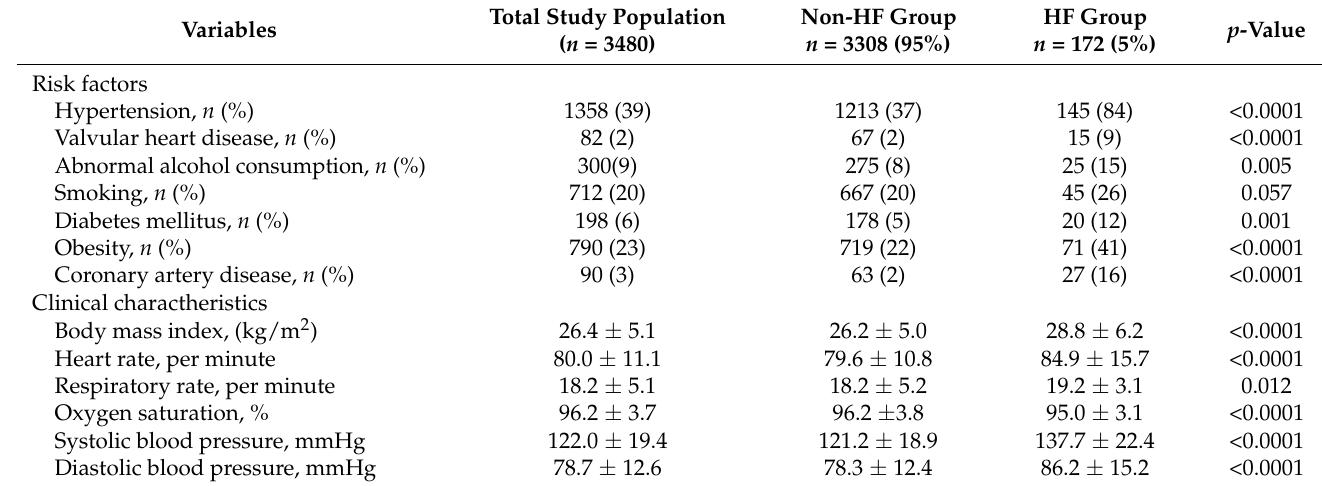
Table 6. Comparison of risk factors and clinical charactheristics between the HF and non-HF groups.